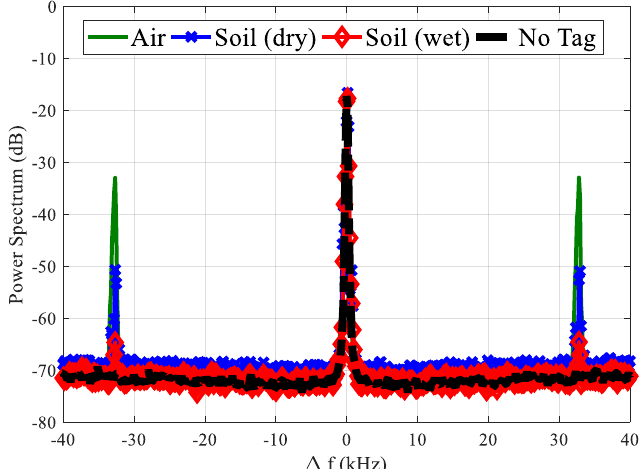
Figure 18. Comparison of tag measured spectrum response at 2 f 0 = 1732 MHz as a function of the offset frequency (∆ f ) for three configurations: (i) tag in the air, (ii) tag buried under dry soil, and (iii) tag buried under the wet soil (VWC 15%).